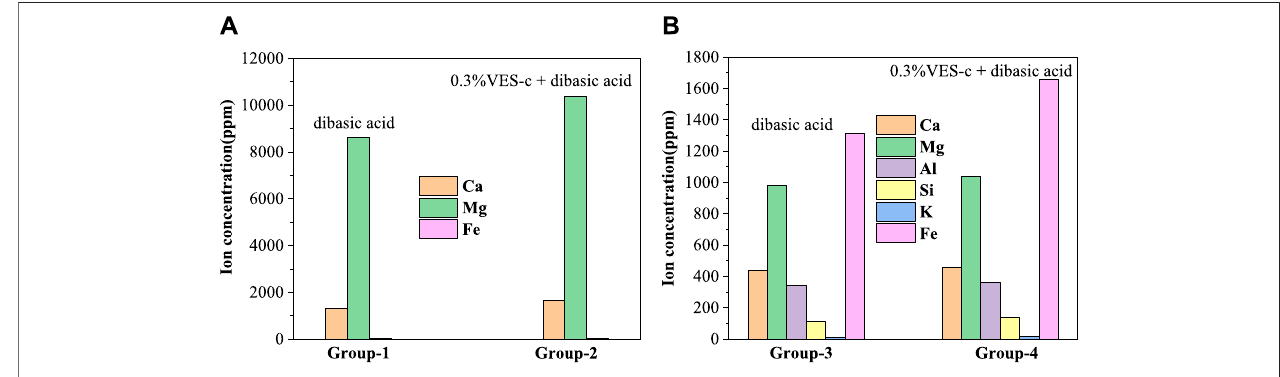
FIGURE 9 | The composition and content of elements in the solution after the acid – rock reaction: (A) dolomite reactions; (B) core reactions.